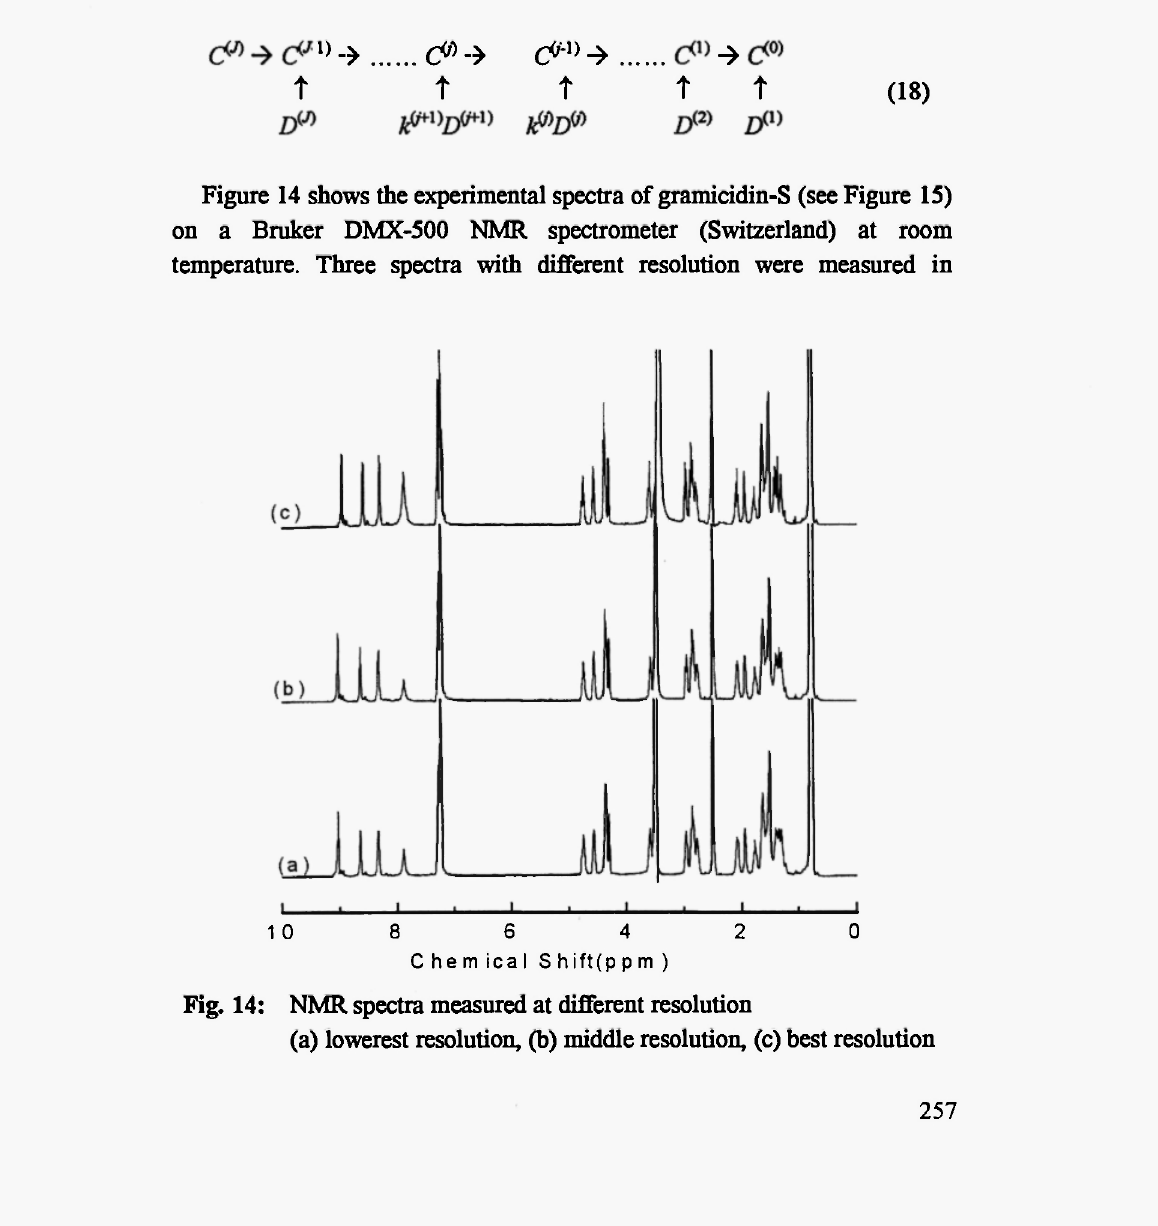
Fig. 14: NMR spectra measured at different resolution (a) lowerest resolution, (b) middle resolution, (c) best resolution